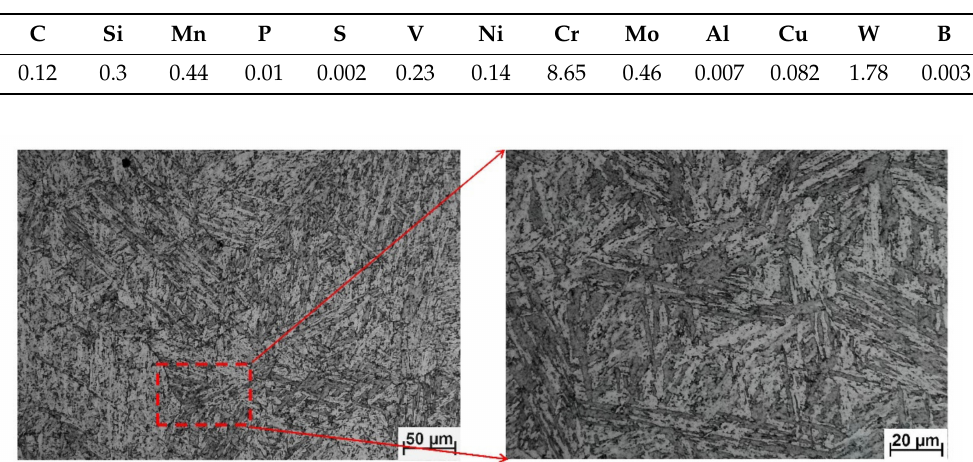
Table 1. Chemical composition (wt. %) of F92 steel.